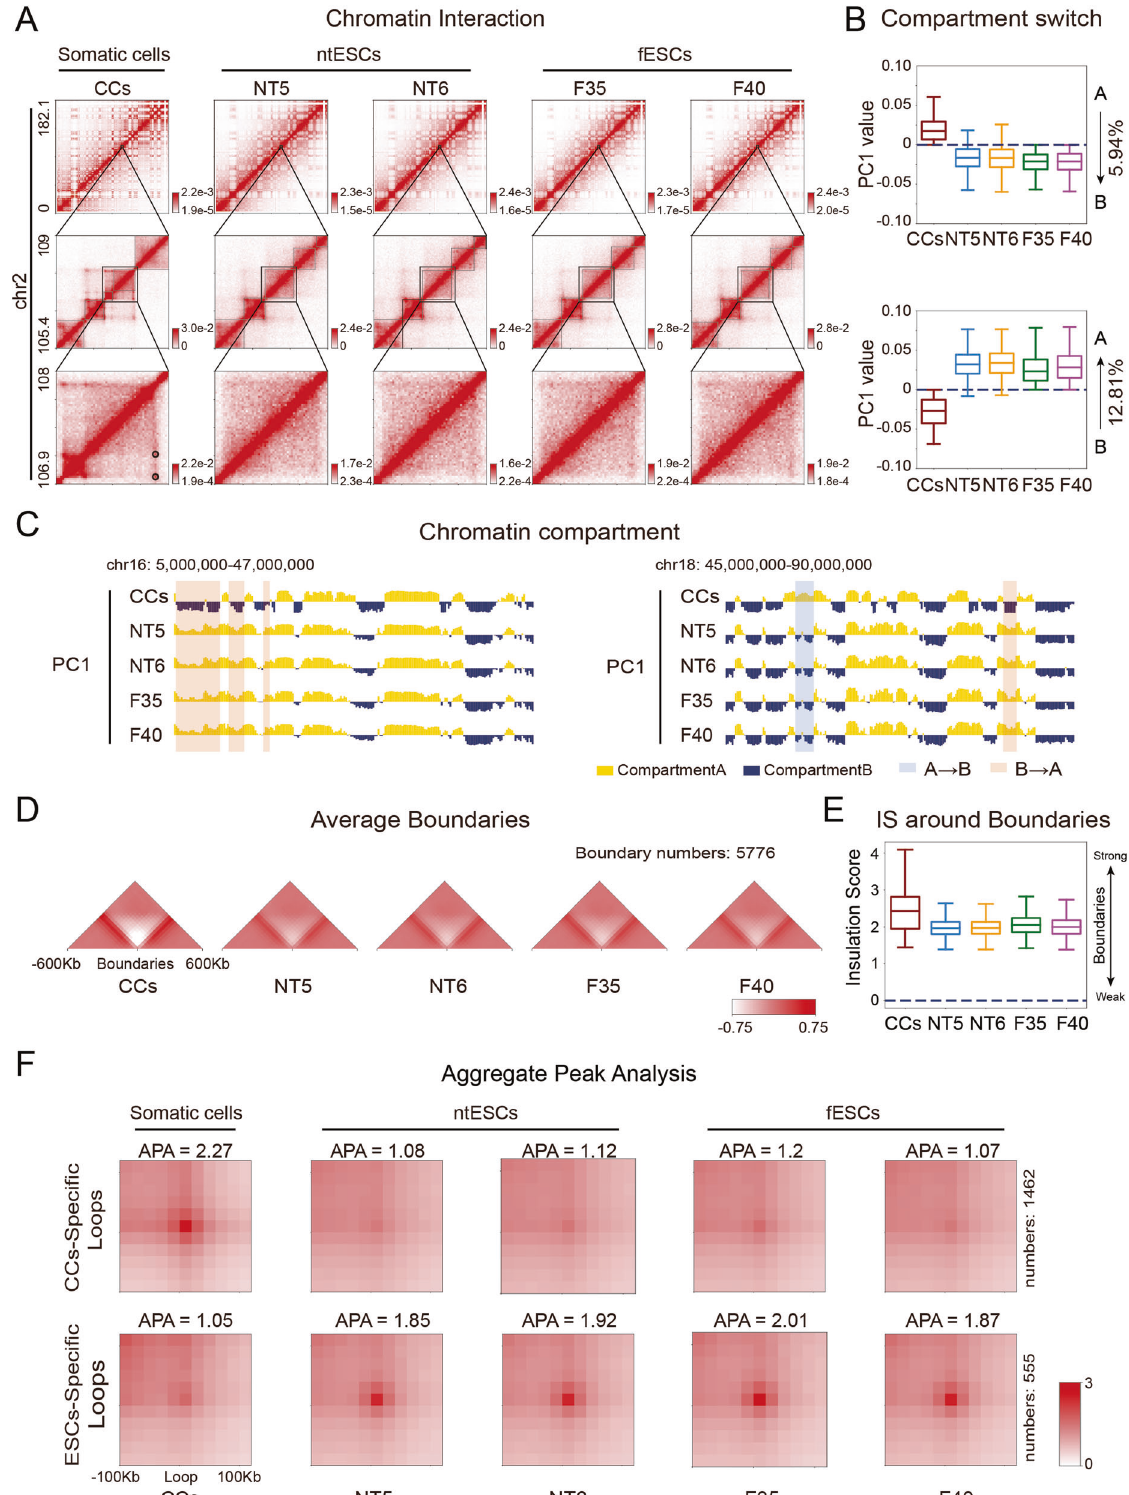
Rewiring of 3D genome in pluripotent and somatic transcription factors We investigated the dynamic changes of chromatin structures in the regions coding for pluripotent TFs. Several chromatin loops (denoted as loop 1/2/3/4/5 in CCs) anchored around gene